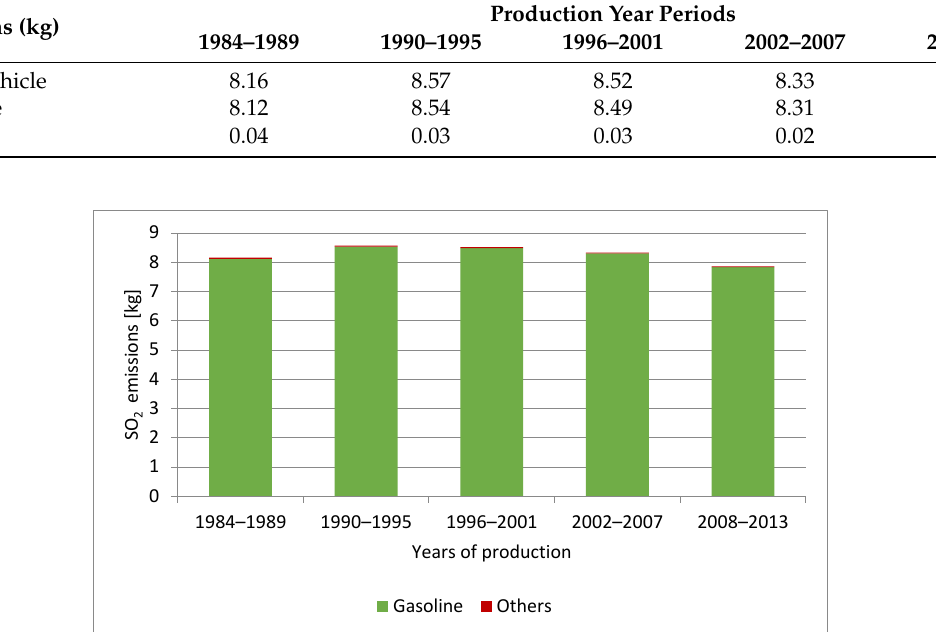
Figure 6. SO 2 emissions for the entire passenger car.